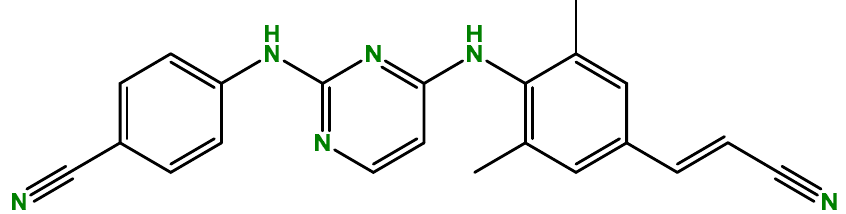
Figure 1. Chemical structure of rilpivirine (developed with ChemBioDraw ® Ultra 13.0. A Chemical Drawing Software. Available online: https://chemdrawdirect.perkinelmer.cloud/js/sample/index.html (accessed on 22 December 2022)).